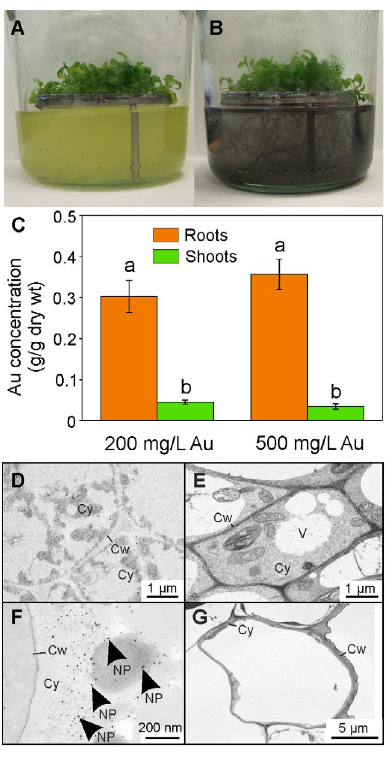
Figure 3. Uptake of gold by Arabidopsis roots. Appearance of six- week-old, hydroponically grown plants (A) before and (B) 24 h after treatment with gold, as K(AuCl 4 ). (C) Levels of gold in plant tissues after 24 h, a and b are significantly different from each other ( p , 0.005) within each treatment. Results are the mean from three biological replicates 6 SD. Electron micrographs of plant tissues dosed with 500 mg/L gold, as K(AuCl 4 ). (D) Leaf mesophyll, (E) leaf vascular tissue, (F) root cortex and (G) root vascular tissue. NP, gold nanoparticle; Cy, cytoplasm; Cw, cell wall, X, xylem; Vw, vascular wall.